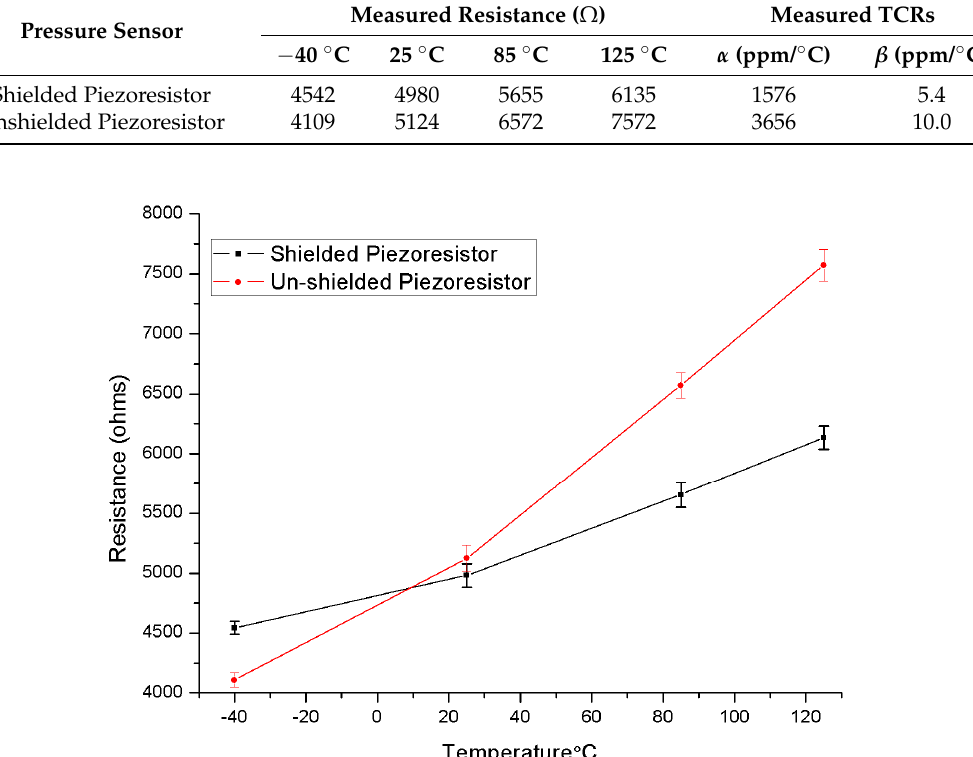
Figure 10 . Temperature sensitivity of shielded and un-shielded piezoresistors. Figure 10. Temperature sensitivity of shielded and un-shielded